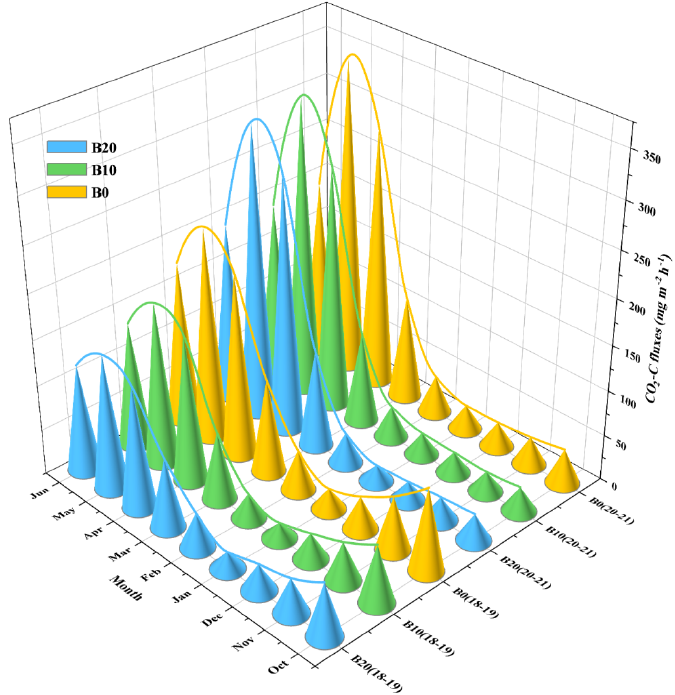
Figure 5. Variations in field CO 2 -C emission fluxes under different amounts of added biochar during the winter wheat growing seasons in 2018–2019 and 2020–2021. Note: The circular cone height represents the CO 2 -C flux value, and the Akima spline curve represents the trend of CO 2 -C fluxes with time. As shown in Figure 6, March–May was the key stage for soil CO 2 -C emissions from wheat fields, and the cumulative CO 2 -C emissions in this stage accounted for 66.94–82.47% of the cumulative CO 2 -C emissions in the whole wheat growing season. The application of biochar significantly reduced the cumulative CO 2 -C emissions from wheat fields ( p < 0.05). Compared with B0, the cumulative CO 2 -C emissions were 584.83–1429.88 kg ha –1 and 514.18–1802.82 kg ha –1 lower under B10 and B20, respectively (Figure 6).